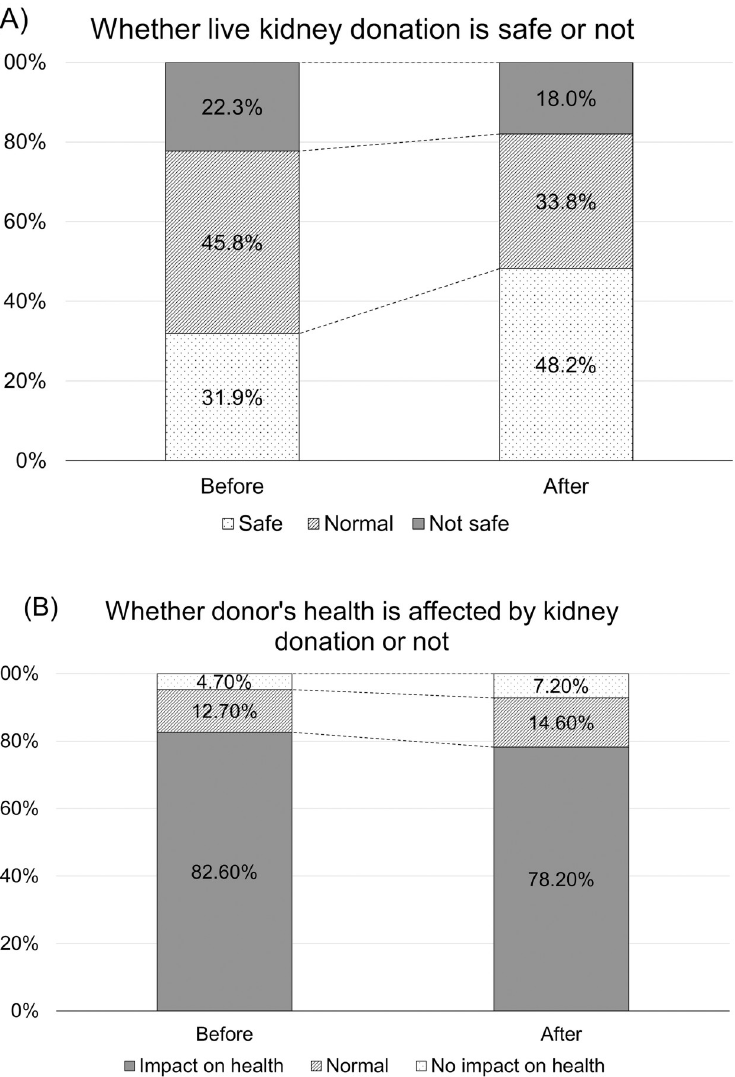
Fig 1. Changes in perception of transplants before and after reading descriptions of living donor kidney transplants. (A) Whether kidney donation is safe. (B) Whether donor’s health is affected by kidney donation of